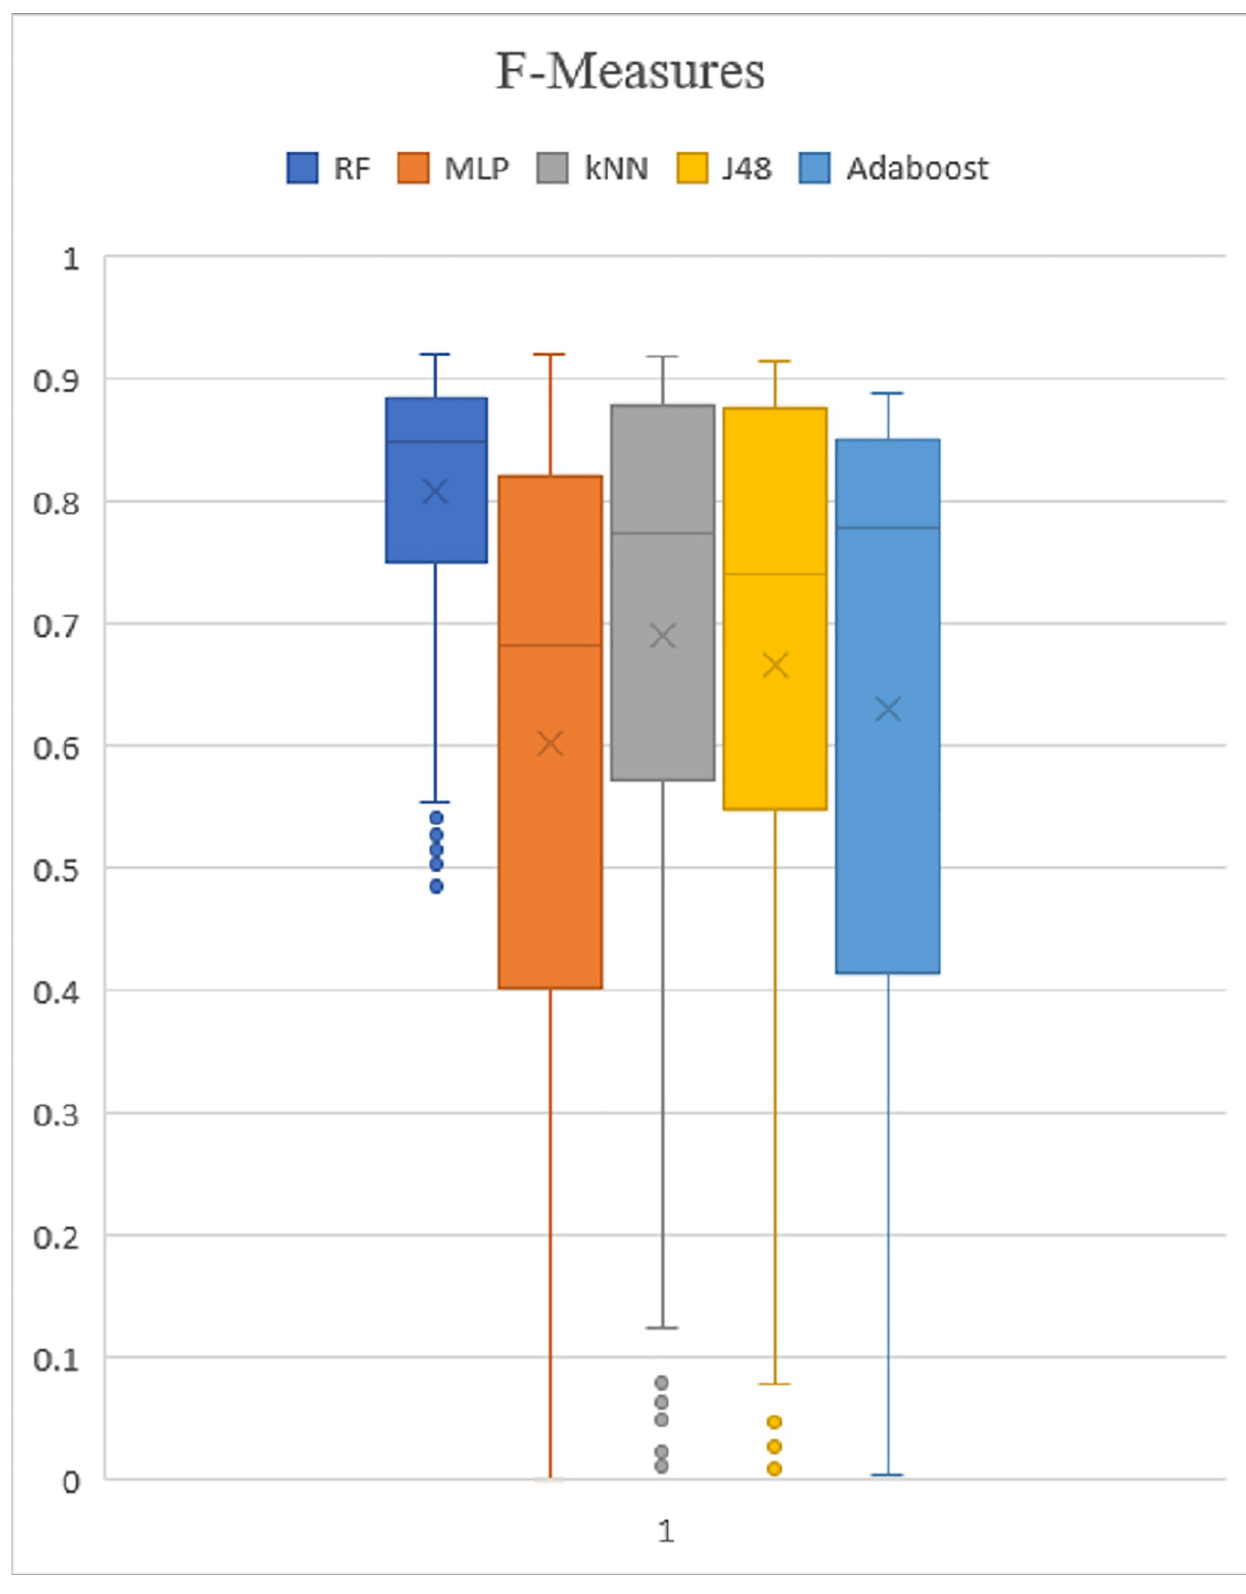
Fig 11. F-Measure. https://doi.org/10.1371/journal.pone.0257968.g011 PLOS ONE | https://doi.org/10.1371/journal.pone.0257968 September 30,